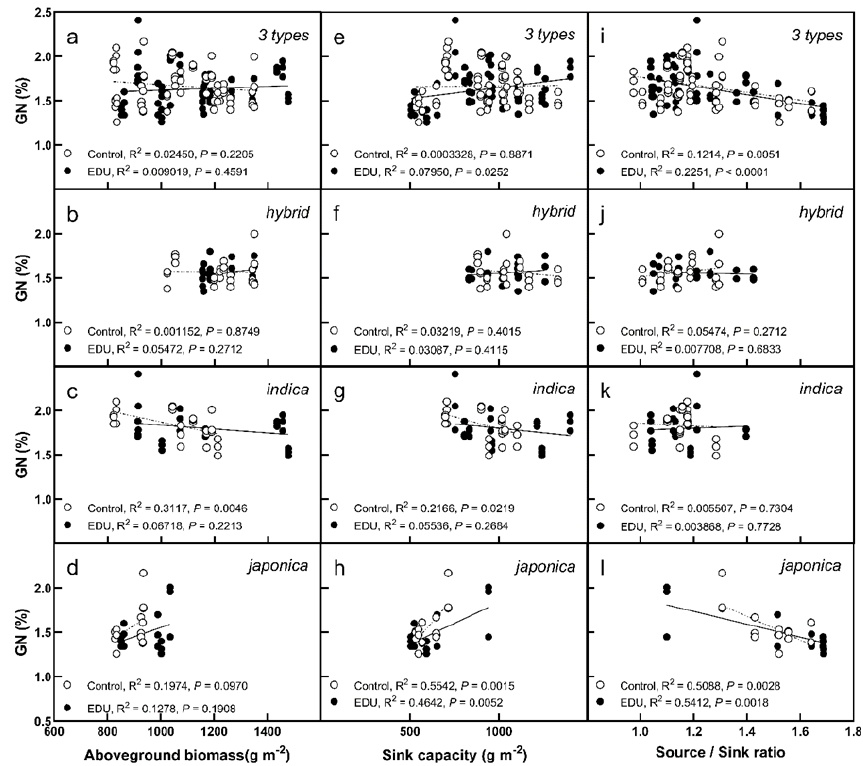
Figure 3. Grain nitrogen (GN) plotted against aboveground biomass, sink capacity, and source/sink ratio. Sink capacity is the result of grain number and grain weight, harvest index is the ratio of grain yield to aboveground biomass. GN and aboveground biomass under control and ethylenediurea treatment across three types of rice cultivars ( a ), and separated by the hybrid ( b ), inbred ( c ), and japonica cultivars ( d ). GN and sink capacity under control and ethylenediurea treatment across three types of rice cultivars ( e ), and separated by the hybrid ( f ), inbred ( g ), and japonica cultivars ( h ). GN and source/sink ratio under control and ethylenediurea treatment across three types of rice cultivars ( i ), and separated by the hybrid ( j ), inbred ( k ), and japonica cultivars ( l ). Solid and dashed lines indicate simple linear regressions.